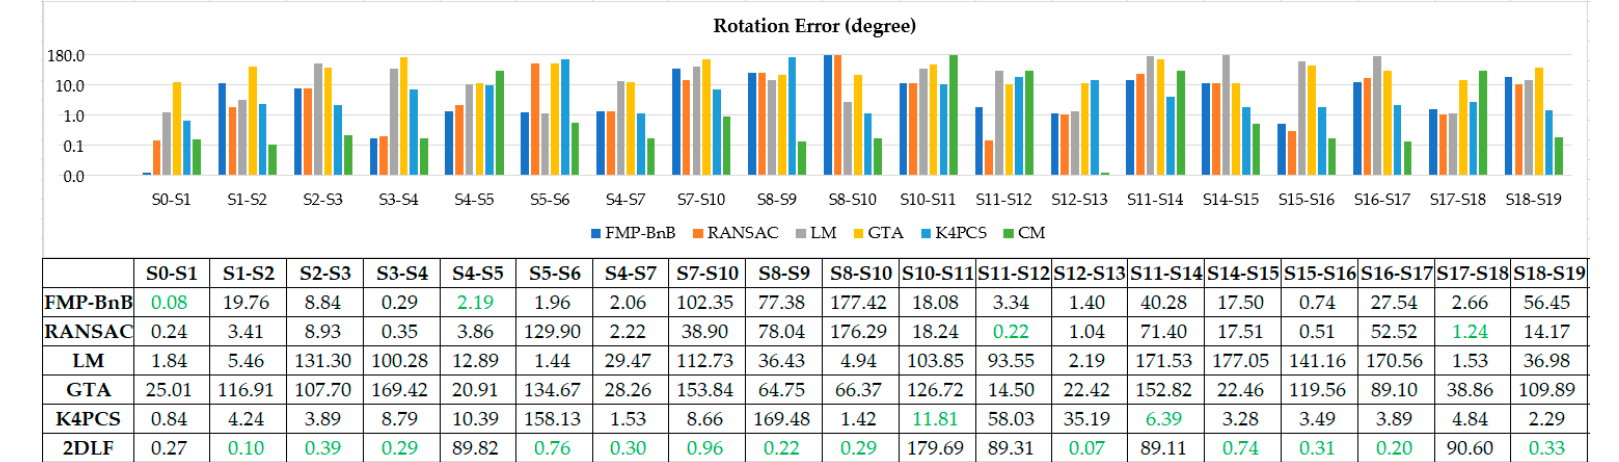
Figure 10. Rotation error of point cloud pairs from dataset CB (the best result of each pair is colored in green).